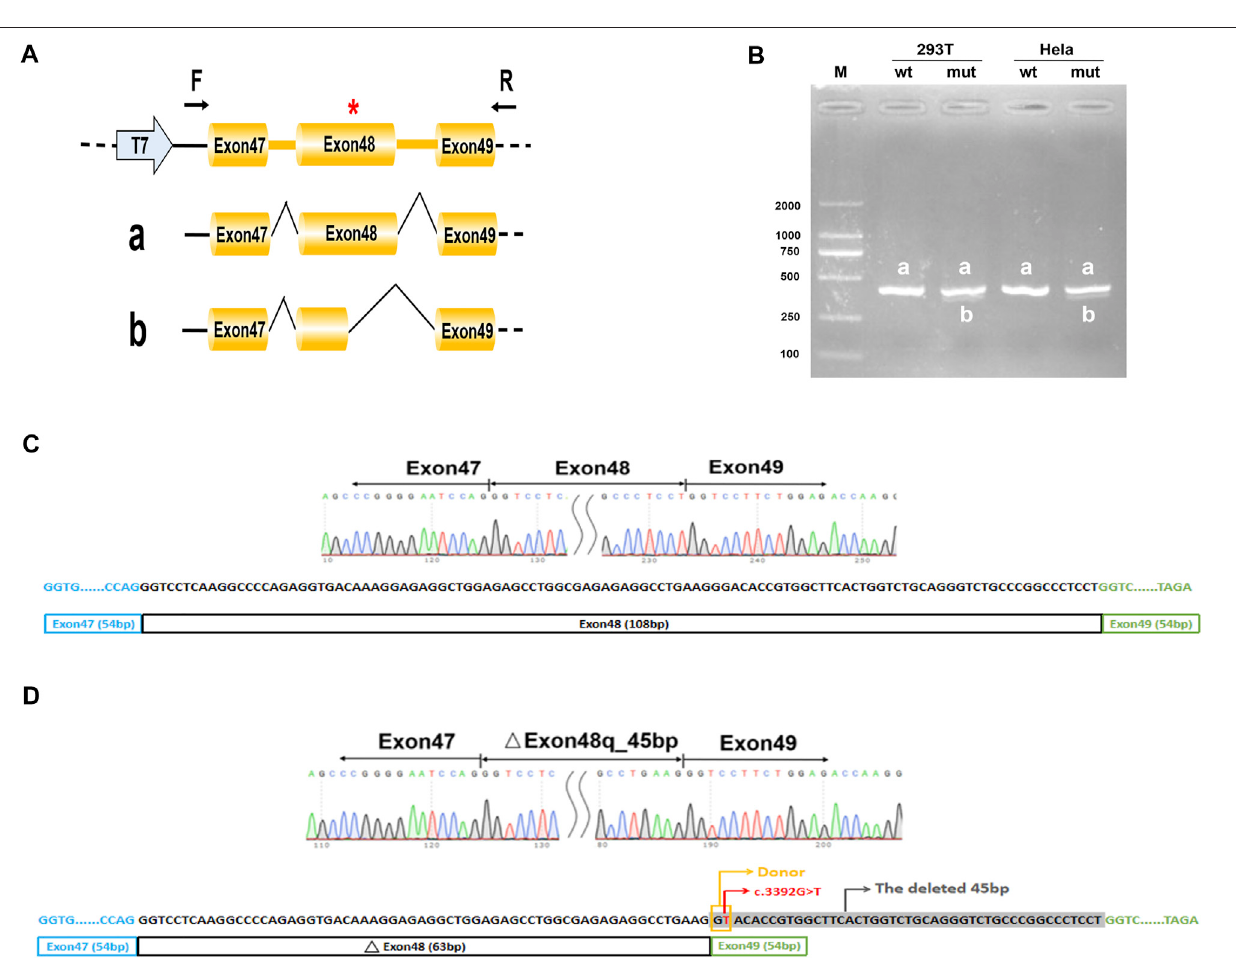
FIGURE 3 | Minigene analysis based on pcMINI-COL2A1-wt/mut recombinant vectors. (A) , Schematic illustration of cloned vectors. Red * indicates the mutation position. (B) Gel electrophoresis of the RT-PCR products in both 293T and HeLa cell lines. M means the DNA marker. Wild type (wt) exhibited a single band, a (full); mutant type (mut) exhibited double bands, a (full) and b (45 bp deletion). (C) Sanger sequencing result of the normal transcript. (D) Sanger sequencing result of the transcript with cryptic splicing caused by the mutation. The two bases in the yellow rectangle form a new donor, and the sequences in grey shade represent the missing 45